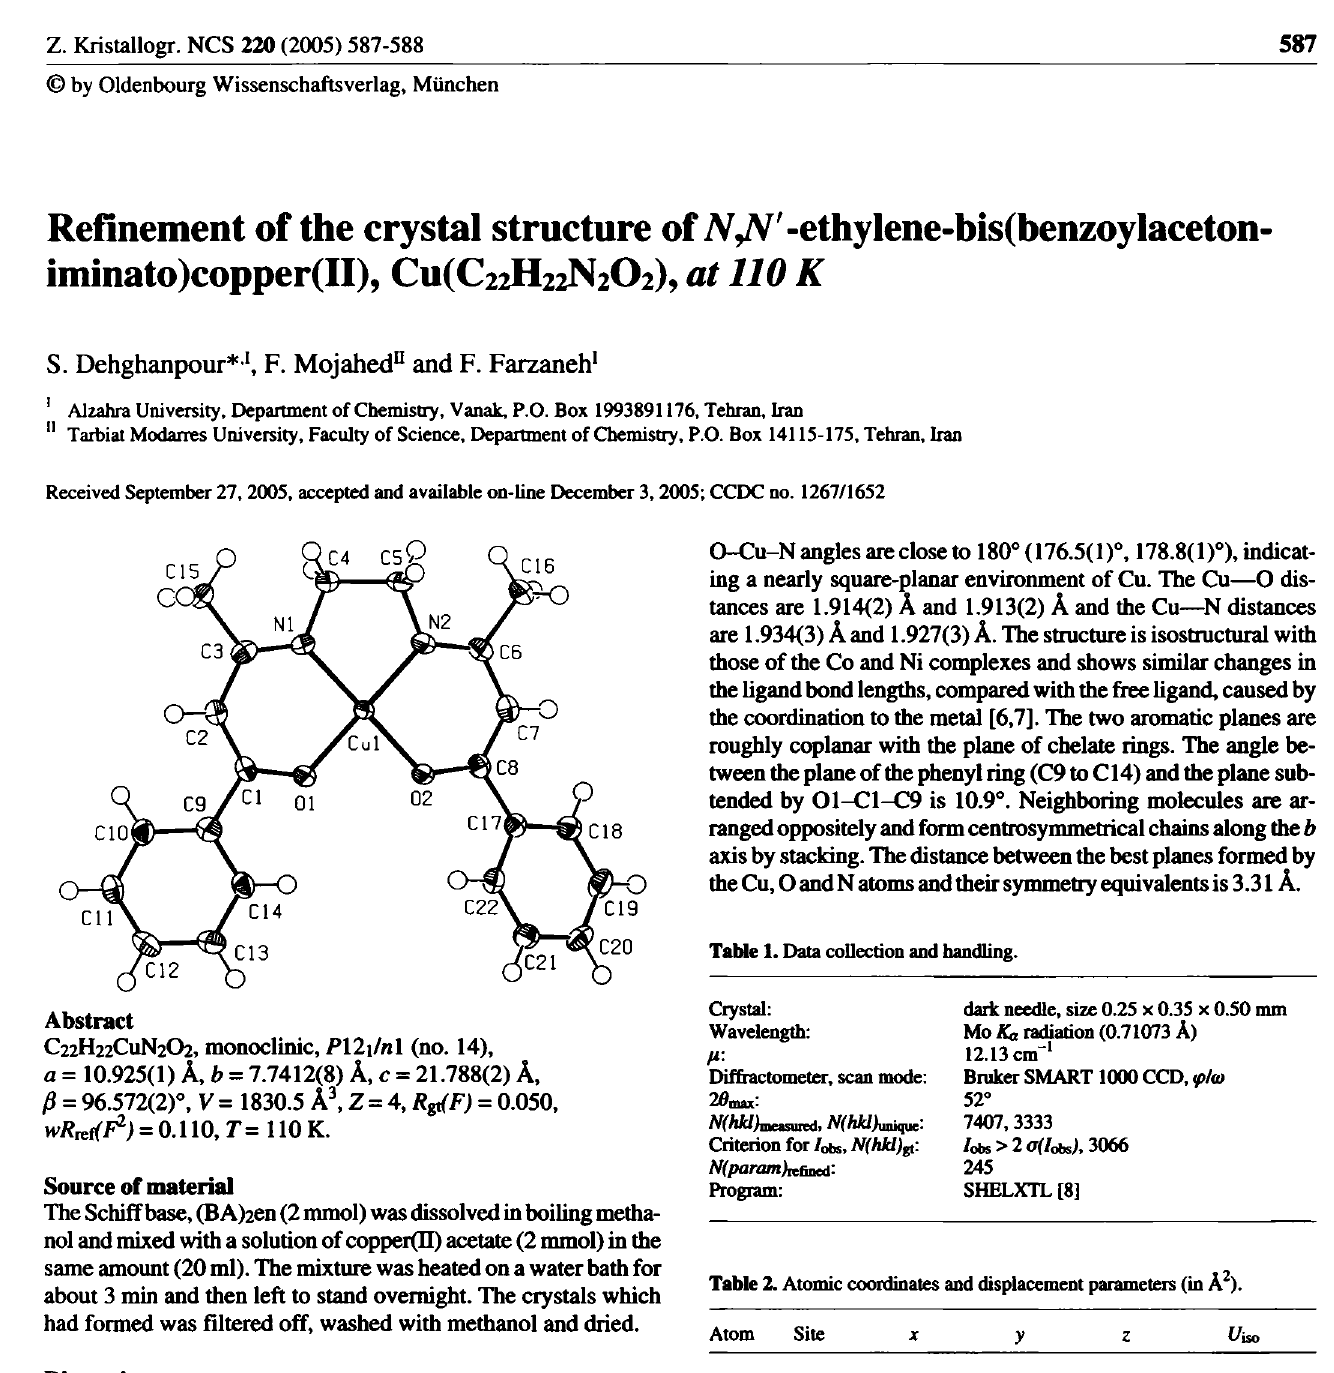
Table 2. Atomic coordinates and displacement parameters (in A 2